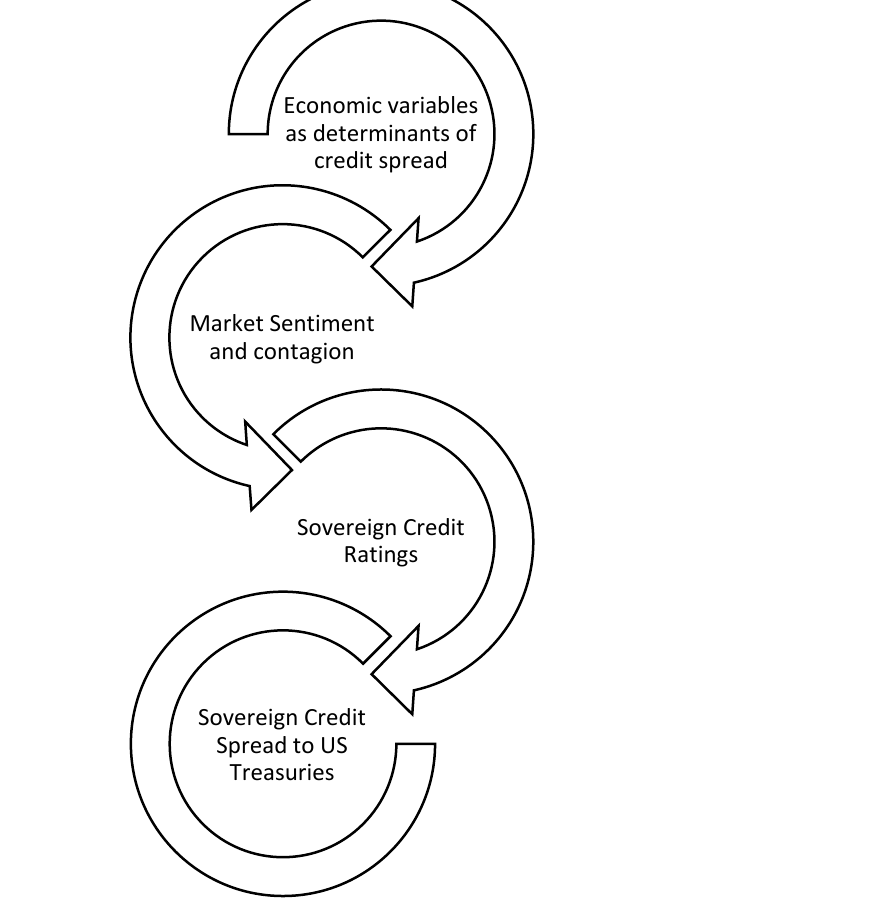
Figure 1. Adapted from Theoretical Frameworks of Rowland and Torres (2004). Created by the author.